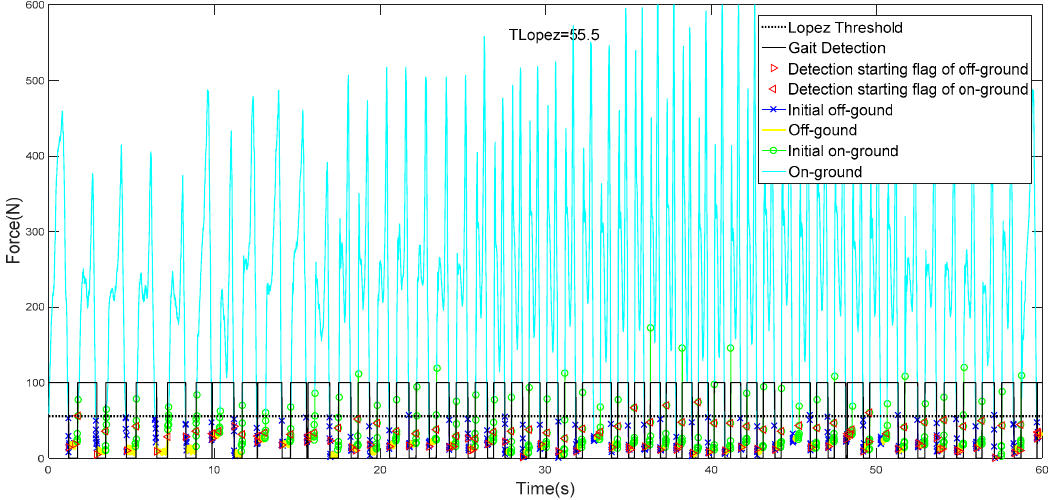
Figure 13. The best result of gait phase detection.